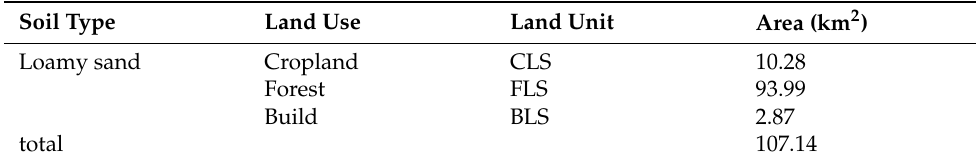
Table 1. Area of different land